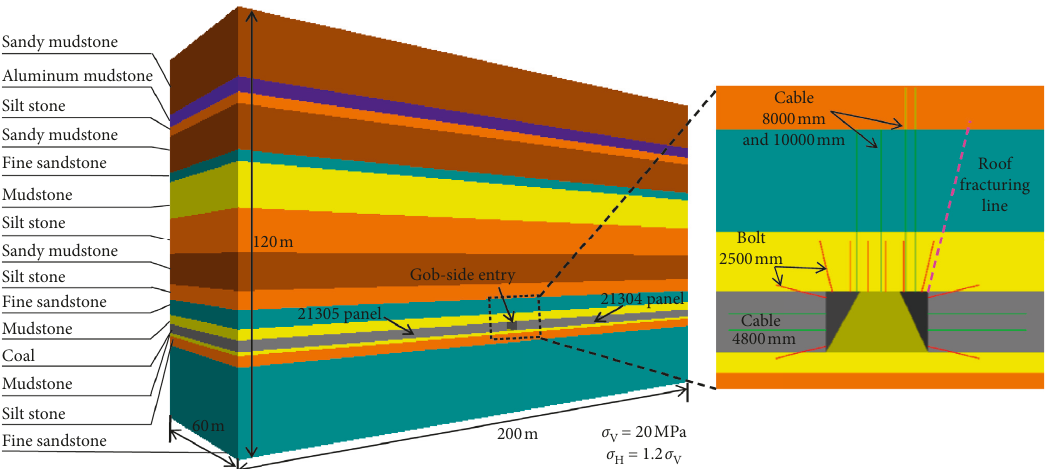
Figure 7: Schematic of the global